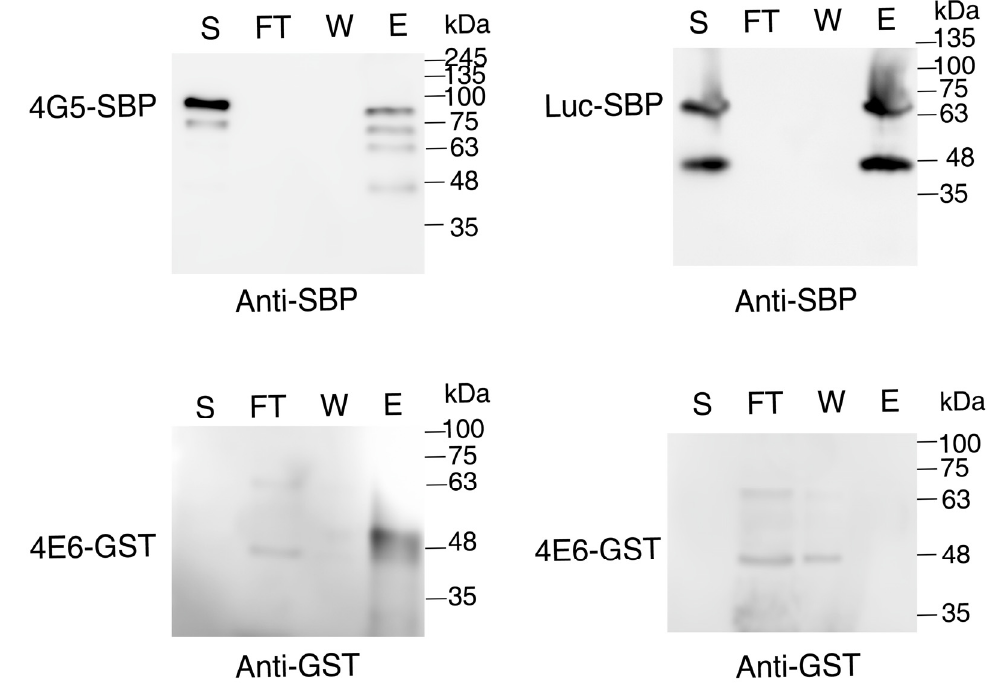
Figure 6. Recombinant GST-LeishIF4E-6 interacts directly with LeishIF4G-5. Lysates of transgenic Leishmania cell lines expressing the SBP tagged LeishIF4G-5 were bound to Streptavidin beads, washed and further incubated with the E. coli cell lysates expressing the recombinant GST tagged LeishIF4E-6 (left panels, top and bottom). After several washes, the beads were eluted with 5 mM Biotin. A Leishmania cell line expressing the transgenic SBP-tagged Luciferase was used as a negative control (right panels, top and bottom). All gels were loaded with aliquots obtained from supernatants of the cell extracts (S, 2%), the flow through (FT, 2%), the wash (W, 25%) and the eluted fractions (E, 25%) were resolved over 12% SDS-PAGE, which were subjected to Western Blot analysis using the specific monoclonal antibodies against the SBP and GST tags. The top panels represent the blot developed with anti-SBP antibodies while the bottom panels represent the blot developed with anti-GST antibodies.